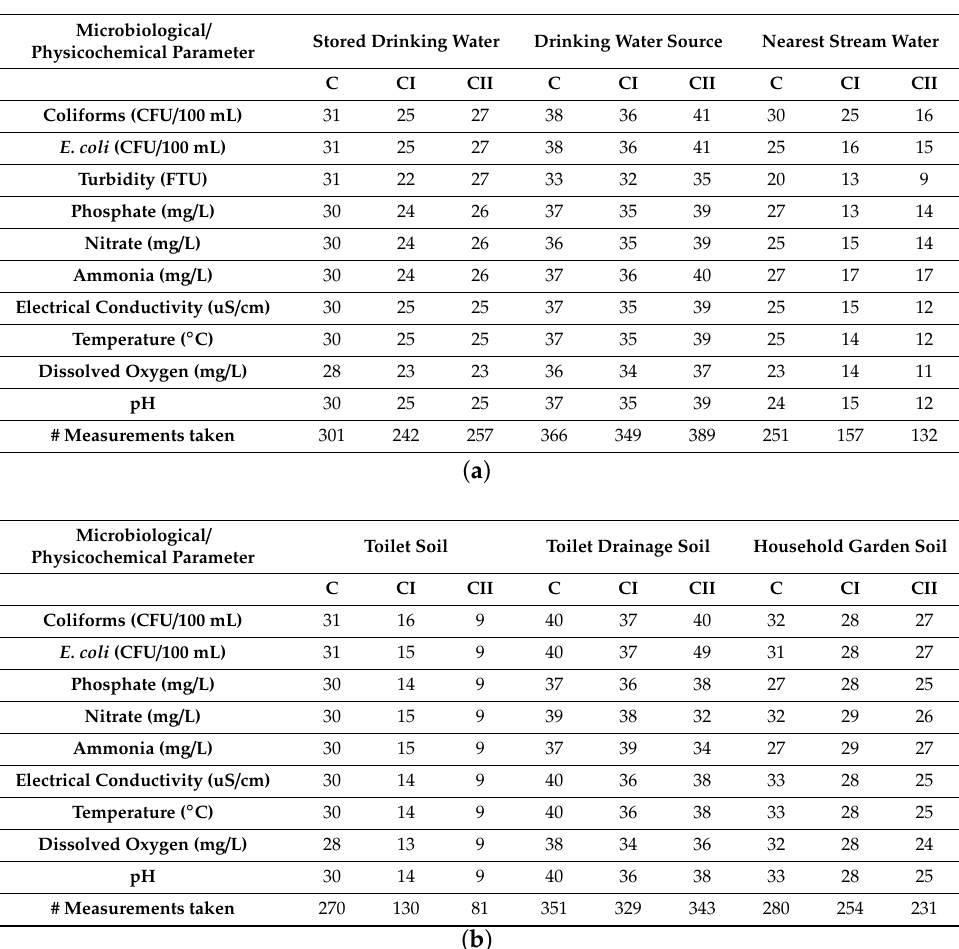
Table A2. Sample sizes for microbiological / physicochemical parameters measured in residential ( a ) water and ( b ) soil (water from soil) samples, Fiji typhoid case-control study, 2014–2015. C = cases; CI = control I; CII = Control II; # = number.